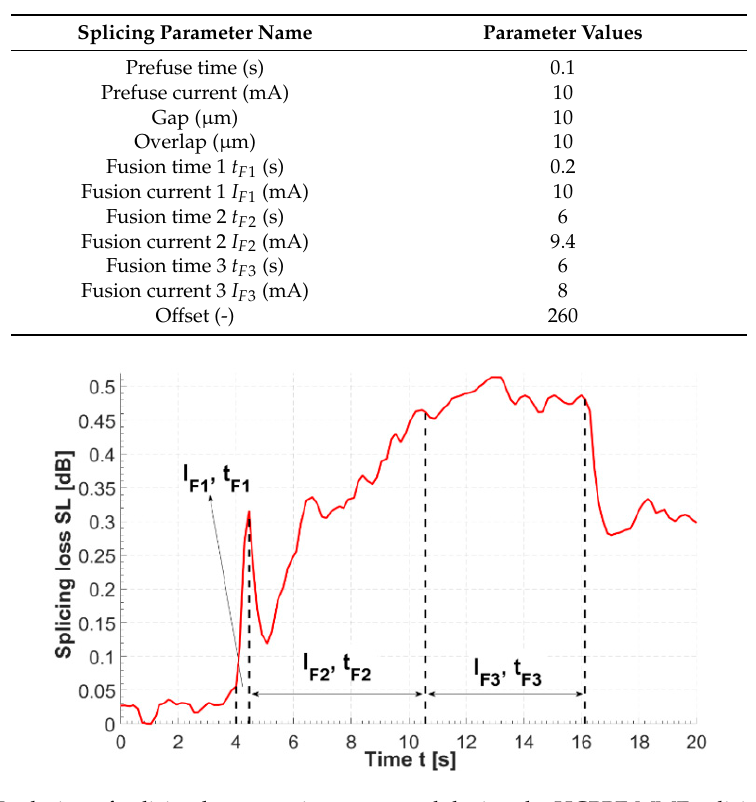
procedure. Dotted lines indicate moments of start and stop of three main splicing phases. SL rise is most intense during phase 1 of splicing (i.e., when the fiber tips are softened and prepared for forming a splice with a high fusion current). The SL value falls almost immediately after the splicing has stopped; the splicers program stops pushing the fibers towards each other, which probably reduces the displacement between the cores of both fibers and in turn positively influences coupling between them in the splice region.